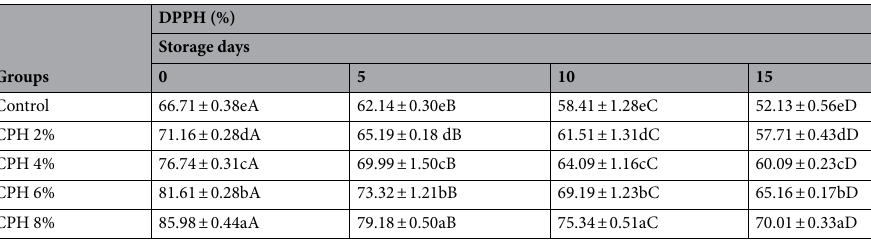
Table 2. DPPH of casein protein hydrolysate (CPH) powder incorporated beef nuggets during storage. CPH: casein protein hydrolysate. All the values are means of triplicate determinations ± Standard Deviation (SD). Means within the column with different small letters are significantly different (p < 0.05) and different capital letters within the row differed significantly.